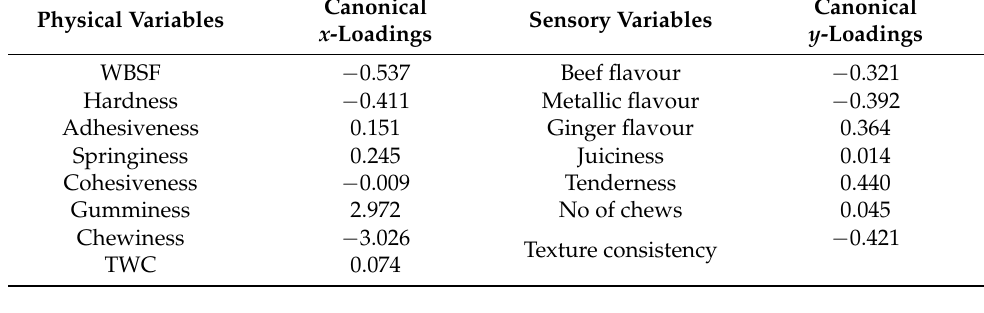
Table 7. Canonical correlation loading of dimension 1 for both X and Y-axis. The X-axis represents the physical variables and Y-axis represents sensory variables of M. biceps femoris with injection treatment (control = without injection, GP injection = ginger powder injection containing zingibain) cooked at 65 ◦ C for 8 h and 12 h under sous vide conditions. WBSF = Warner-Bratzler shear force, TWC = total water content.